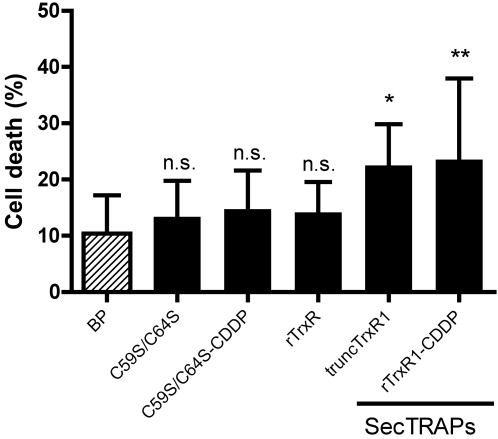
C59S/C64S mutant SecTRAPs cannot induce cell death in A549 cells.A549 cells were treated with 100 ng of the C59S/C64S mutant rat TrxR or native rat TrxR1 preparations, with or without cisplatin (CDDP) derivatization of the Sec residue, using BioPORTER, as indicated in the figure and described further in the text. Cell death was significantly increased after treatment with truncated TrxR or TrxR1 derivatized with cisplatin compared to control using only BioPORTER, whereas the other proteins gave no significant difference in cell death compared to the control (n.s., p>0.05; *, p<0.05; **, p<0.01).